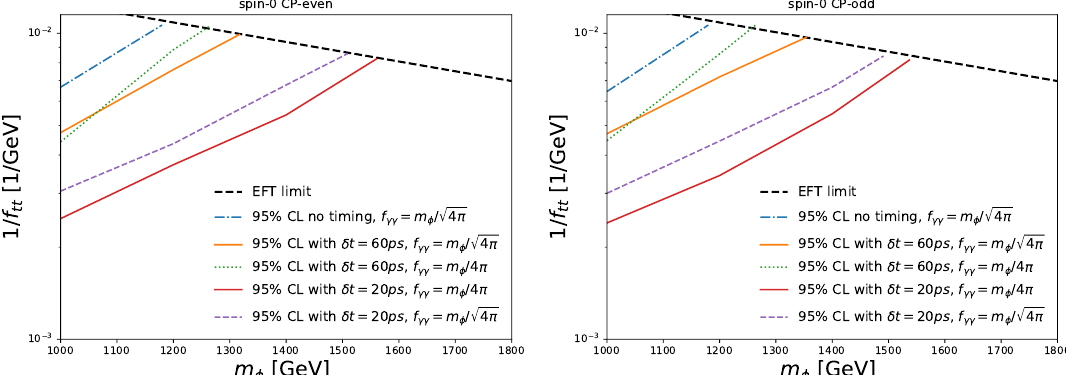
) plane. Regions above the curves are ¯ tt